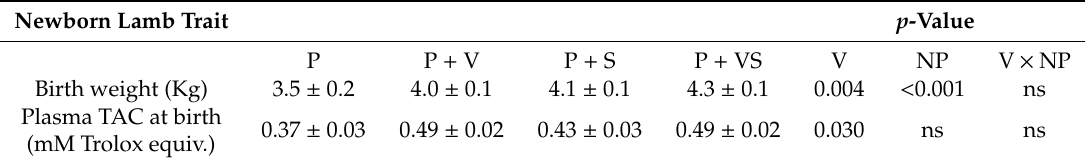
Table 1. E ff ects of maternal nutritional plane and supplementation with vitamins C and E on newborn birth weight and antioxidant status in ewes kept in extensive grazing under Patagonian conditions. Newborn Lamb Trait p -Value P P + V P + S P + VS V NP V × NP Birth weight (Kg) 3.5 ± 0.2 4.0 ± 0.1 4.1 ± 0.1 4.3 ± 0.1 0.004 < 0.001 ns Plasma TAC at birth 0.37 ± 0.03 0.49 ± 0.02 0.43 ± 0.03 0.49 ± 0.02 0.030 ns ns (mM Trolox equiv.)